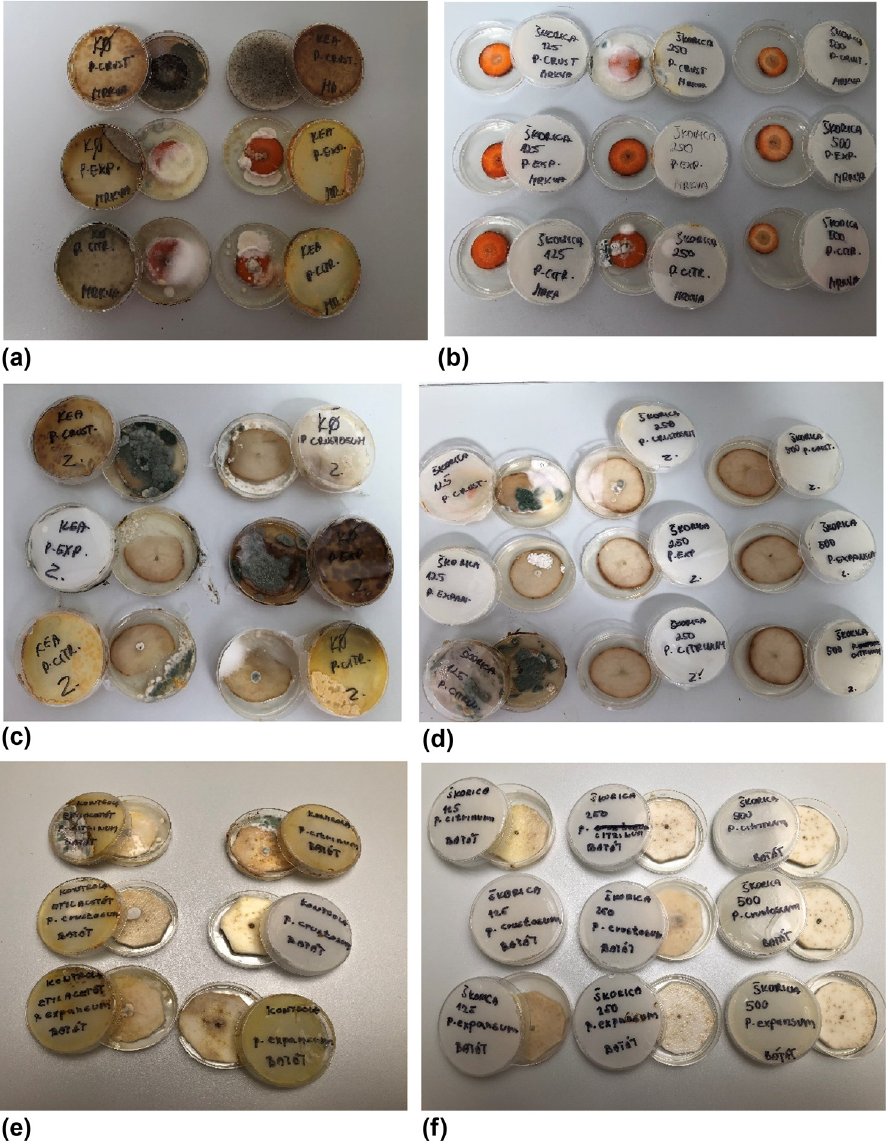
Figure 2: In situ antimicrobial evaluations of vegetables with Penicillum spp. in vapour phase. ( a ) control sample of carrot inoculated with fungi; ( b ) experimental group of carrot inoculated with P. crustosum , P. citrinum , and P. expansum at a concentration of 125, 250, and 500 µL/plate; ( c ) control sample of potato inoculated with molds; ( d ) experimental group of carrot with P. crustosum , P. citrinum , and P. expansum in a concentration of 125, 250, and 500 µL/plate; ( e ) control sample of sweet potato with inoculated with molds; ( f ) experi - mental group of sweet potato inoculated with P. crustosum , P. citrinum , and P. expansum in concentration of 125, 250, and 500